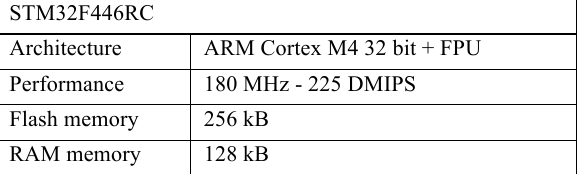
Table 2. STM32F446RC Specifications Figure 6 and Figure 7 show the system integrated on a PCB and mounted on a plastic